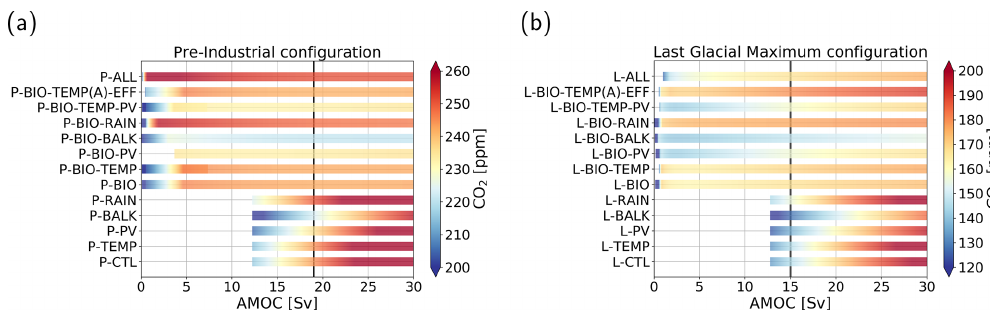
Figure 3. Atmospheric p CO 2 in parts per million (color shading) under varying AMOC strength in sverdrups for the cases considered in Table 2. (a) Pre-industrial configuration. (b) Last Glacial Maximum configuration. Note that the range of the color shading differs between the two configurations and that some CO 2 concentrations fall outside the displayed range. The AMOC ranges of the bars differ, because for some cases the steady solution becomes nonphysical (e.g., negative concentrations or large subzero temperature). The vertical black lines represent the AMOC strength in the original